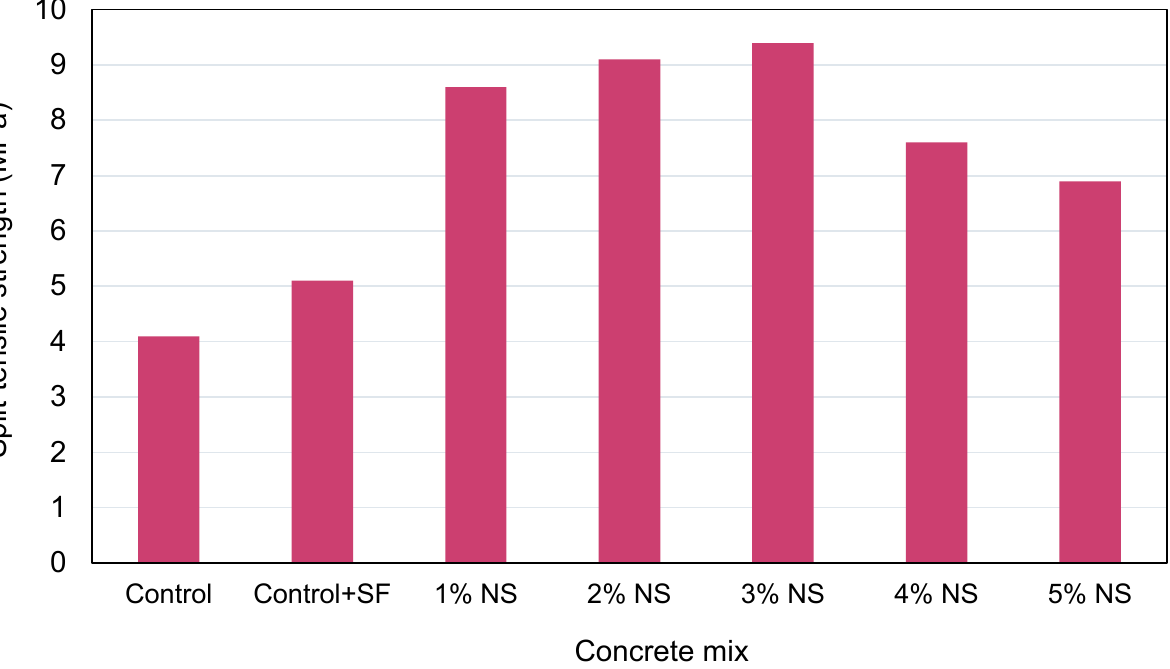
Figure 8. Influence of nano-silica dosage on split-tensile strength [131].